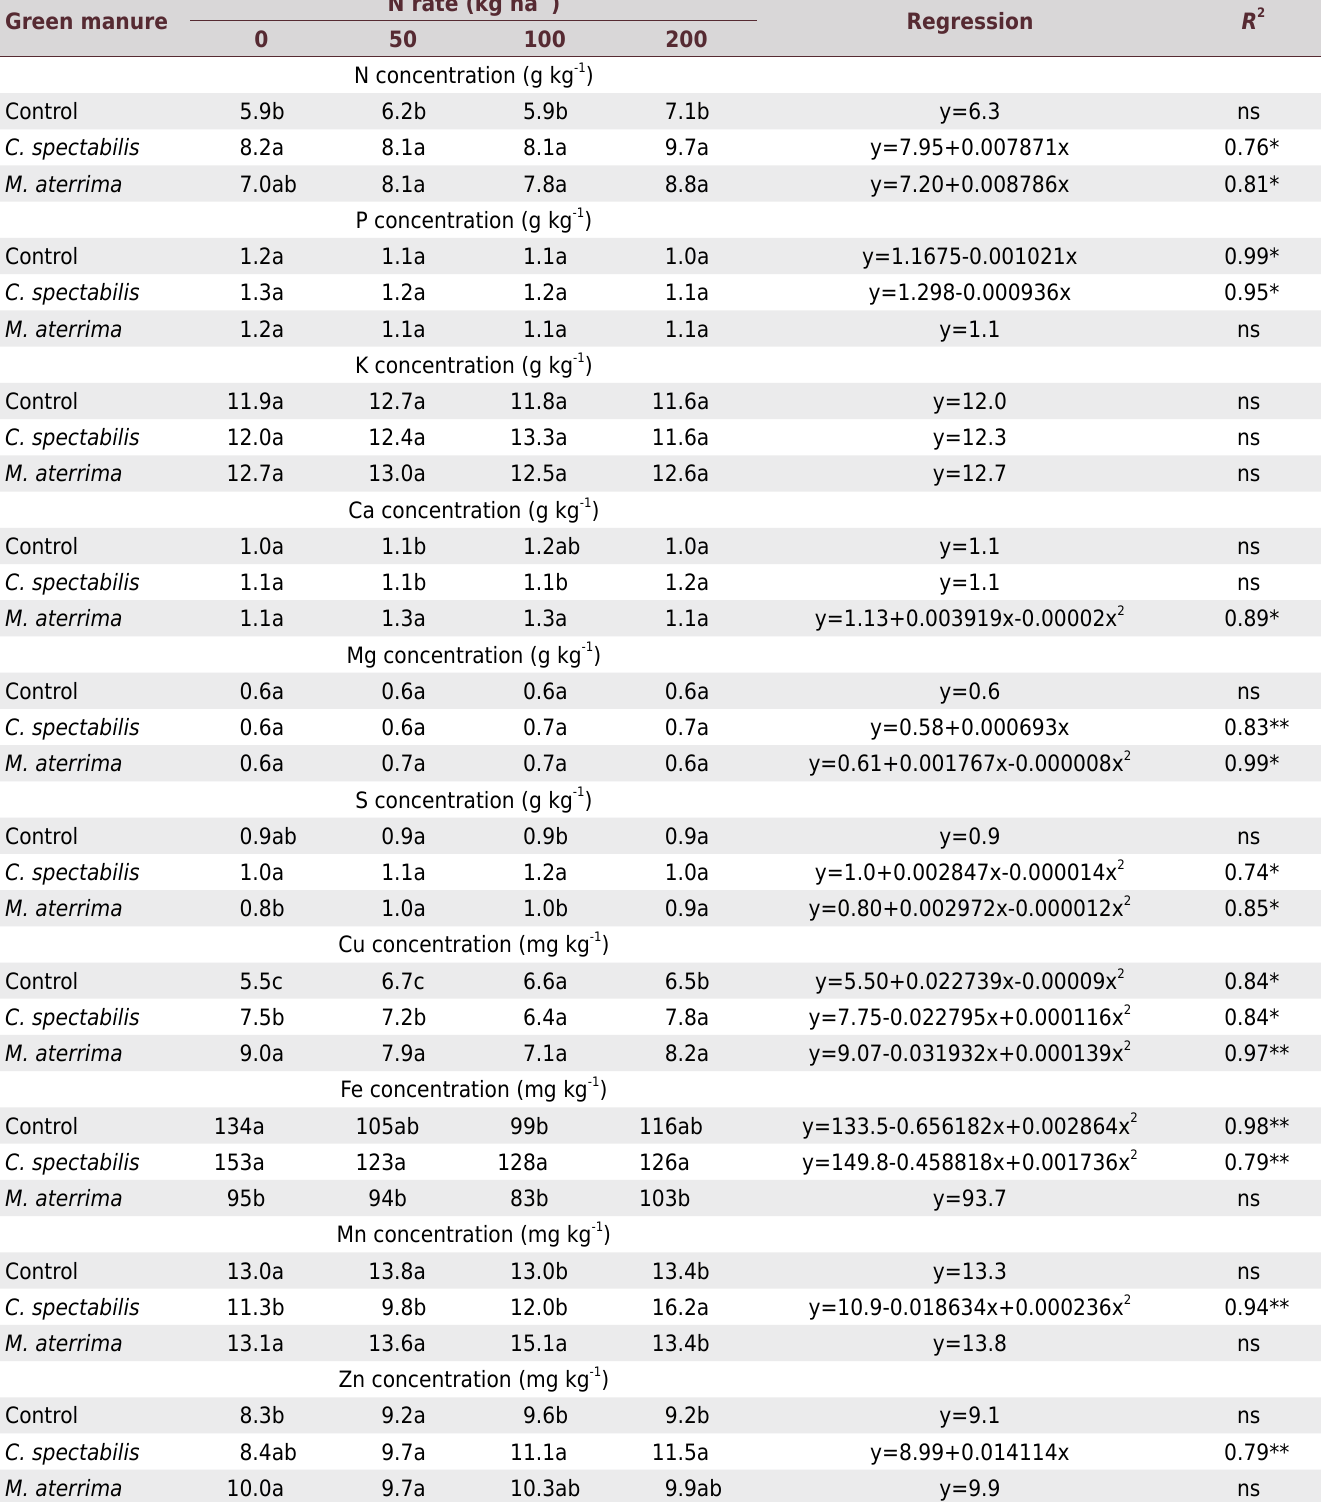
Table 6. Green manure × N rate interaction for nutrient concentration in the storage roots of sweet potato. Data are the means of the two agricultural years N rate (kg ha -1 Green manure